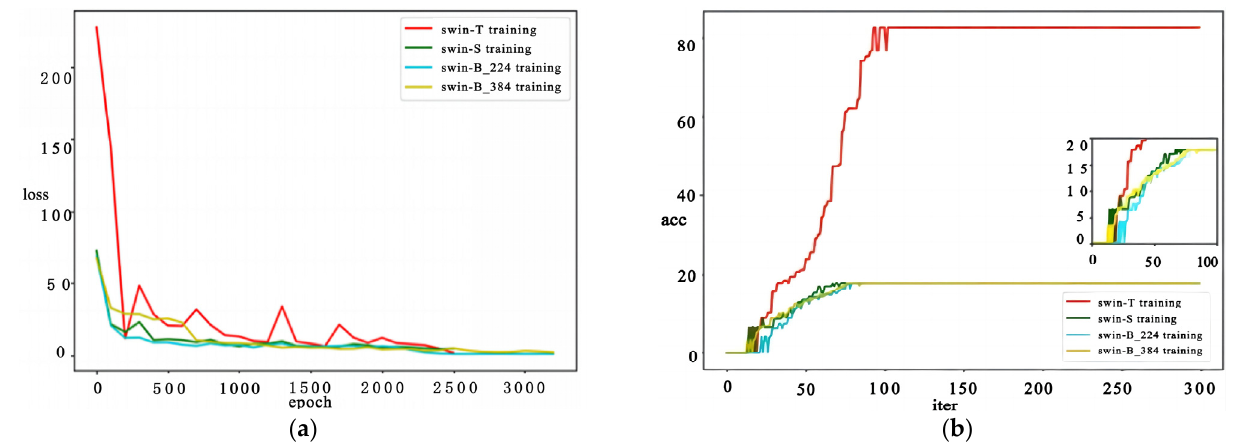
Figure 4. Comparison of loss and accuracy for different models in training. ( a ) Loss for training; ( b ) Accuracy for training.